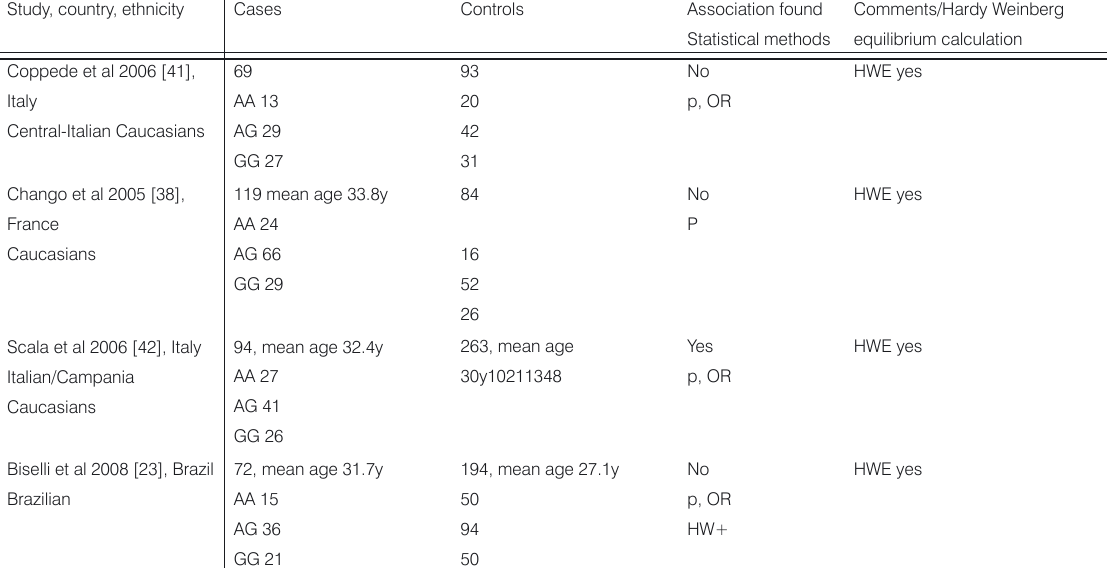
Table 6. Characteristics of studies on RFC1 80 A>G polymorphisms in mothers of DS